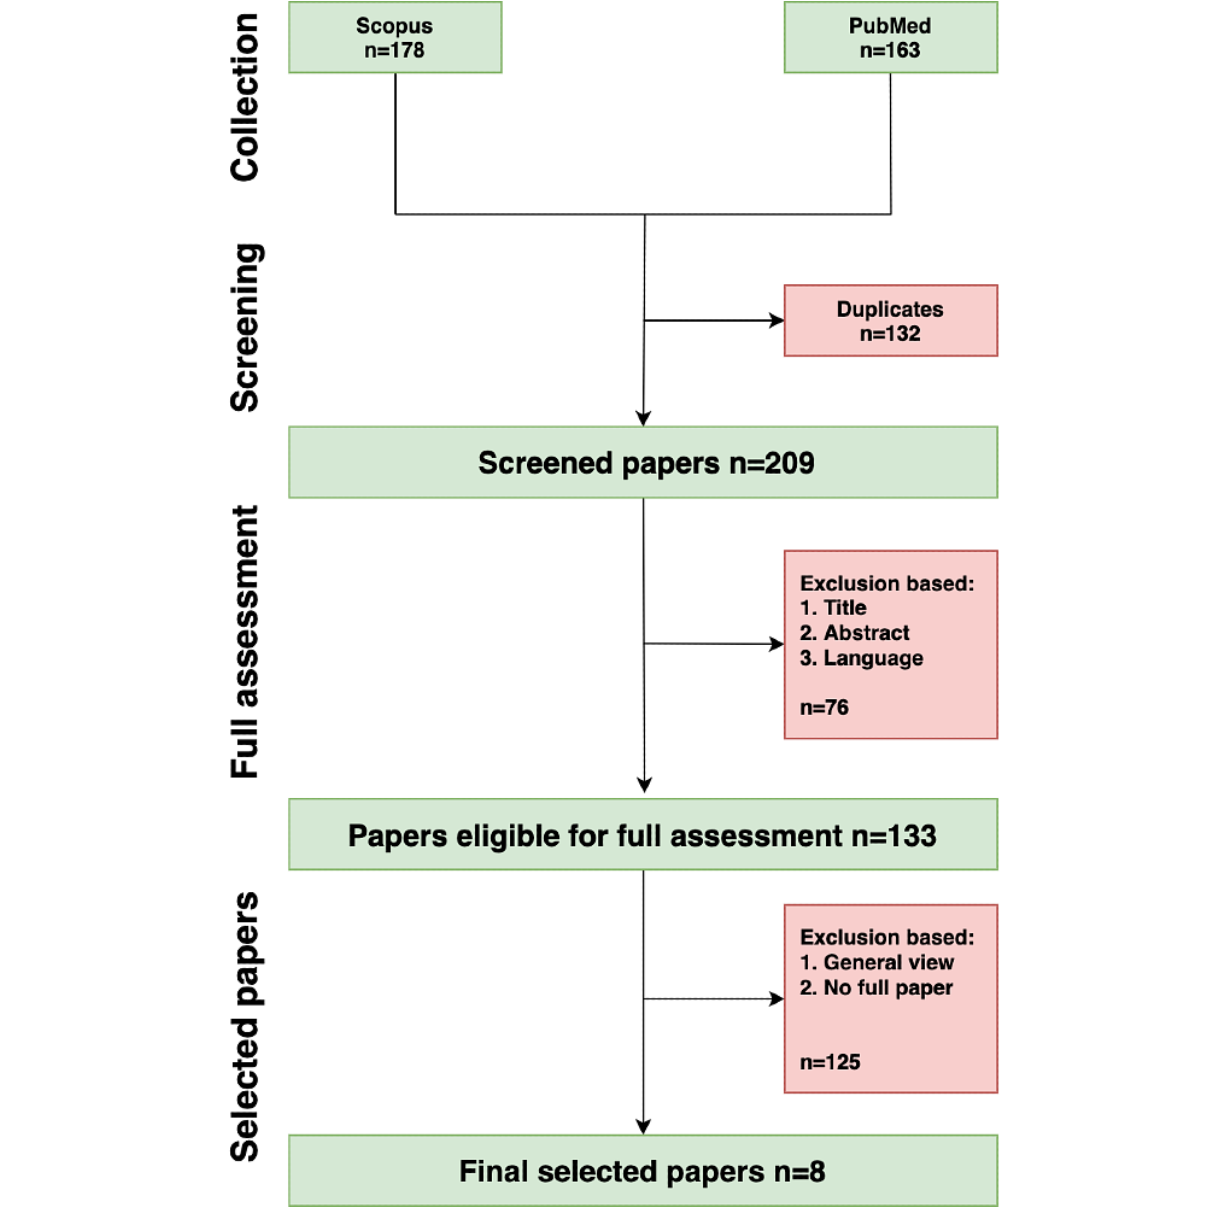
Figure 2. Process of scoping